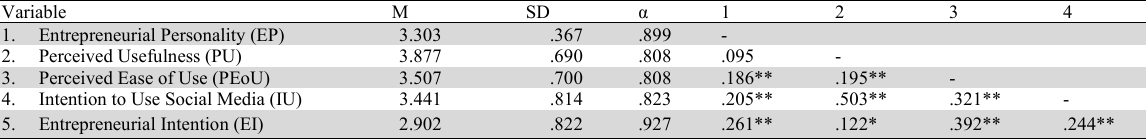
Mean, standard deviation, and correlation of study variable Variable M